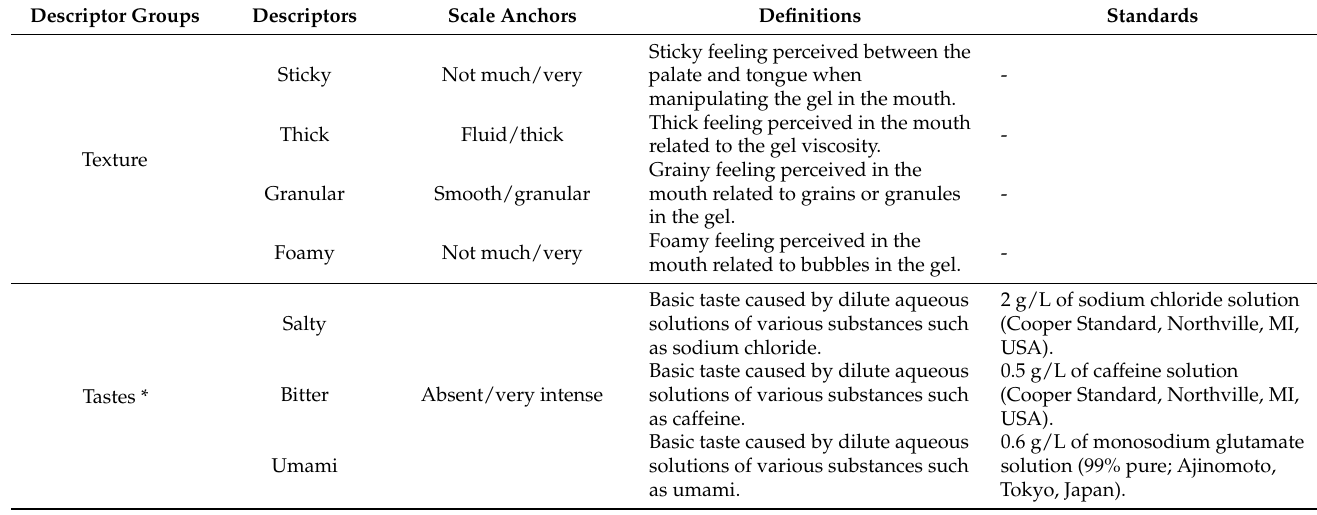
Table 2. Sensory descriptors, evaluated by 21 judges, with their definitions and